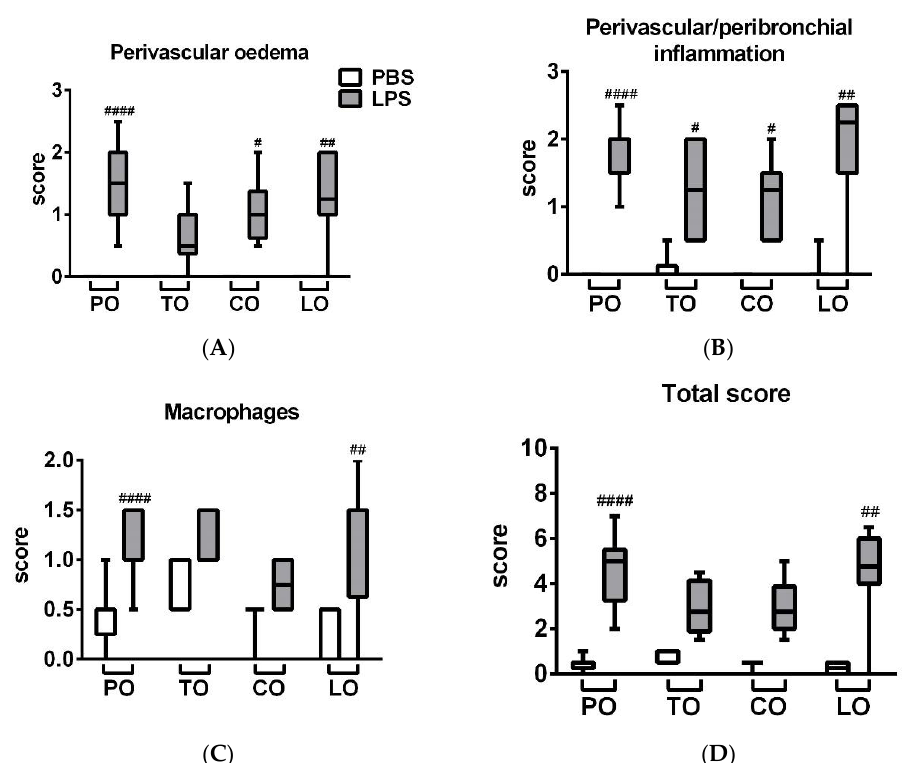
Figure 3. Semiquantitative evaluation of ( A ) perivascular and peribronchial edema, ( B ) accumulation of neutrophil granulocytes, ( C ) macrophages and ( D ) total score of lung histopathological alterations ( n = 8 – 10/group, # p < 0.05, ## p < 0.005, #### p < 0.000 vs. respective PBS-treated group) are demonstrated in box plots showing the median, upper/lower quartile, and maximum/minimum values.